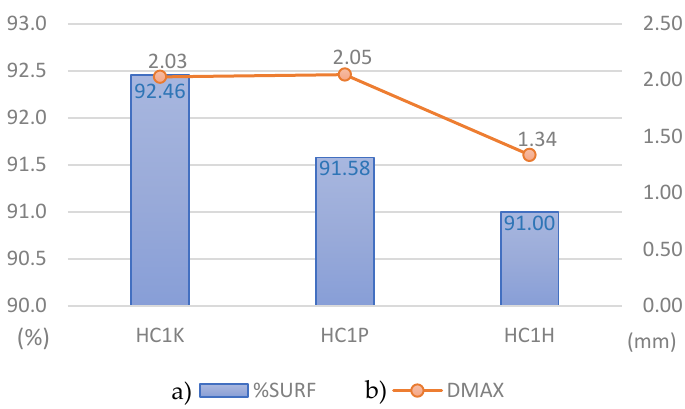
Figure 12. Results of simulations performed with different hardening criteria: Krupkowsky (HC1K), Power Law (HC1P) and Hollomon (HC1H). ( a ) Bar Chart with % Surface with distance between Real and Simulation Parts < 0.5 mm; ( b ) Linear Graph with maximum distance between Real Piece and Simulation Piece.